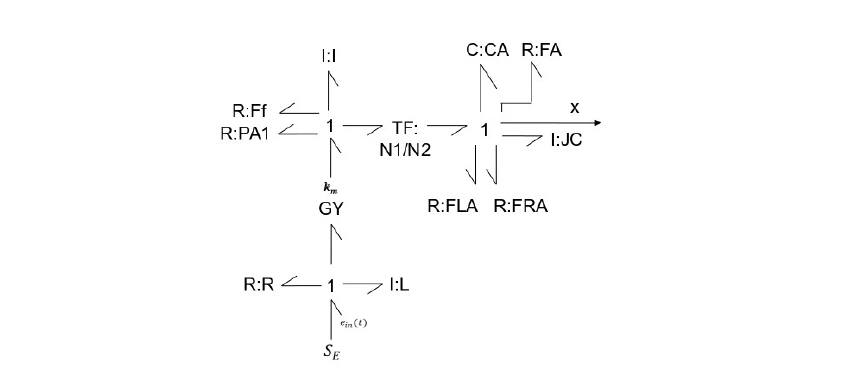
Figure 8. Block diagram of the ACV actuator with a one stage